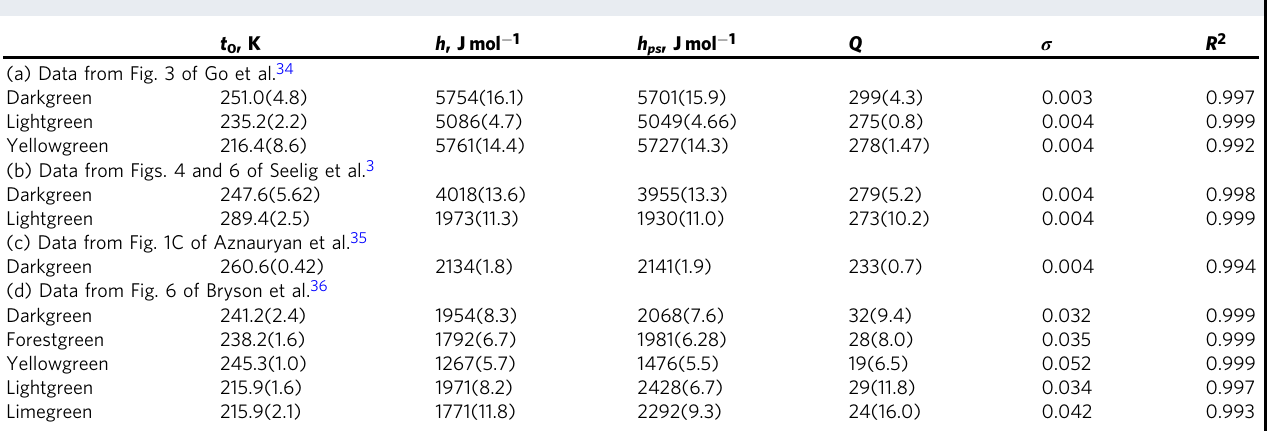
Table 1 Fit results with errors in brackets (percents).